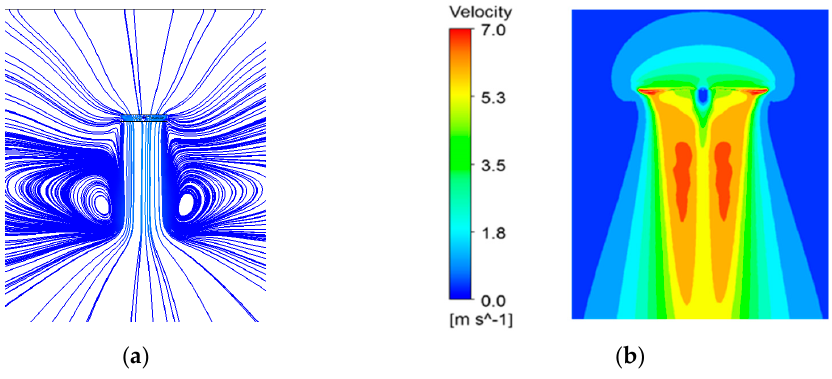
Figure 12. Downwash of the rotor. ( a ) Streamline; ( b ) velocity.